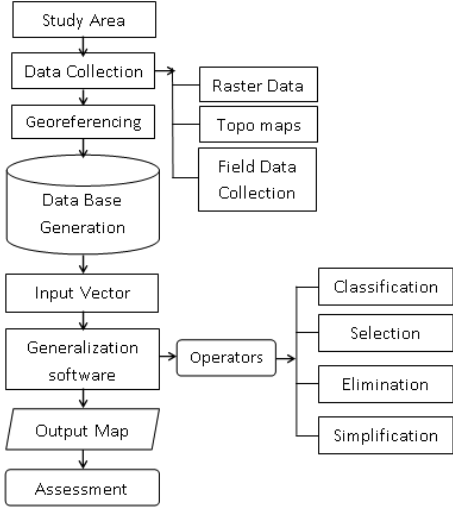
Figure 2: Methodology of the research To evaluate the result obtained from generalization, “Topographic map of Uttaranchal 1:50 000, 53 J/3”, and “Guide map of Dehradun 1:25 000” was used. On-screen digitization and analysis was done using ArcGIS software. Image processing and merging accomplished using ERDAS